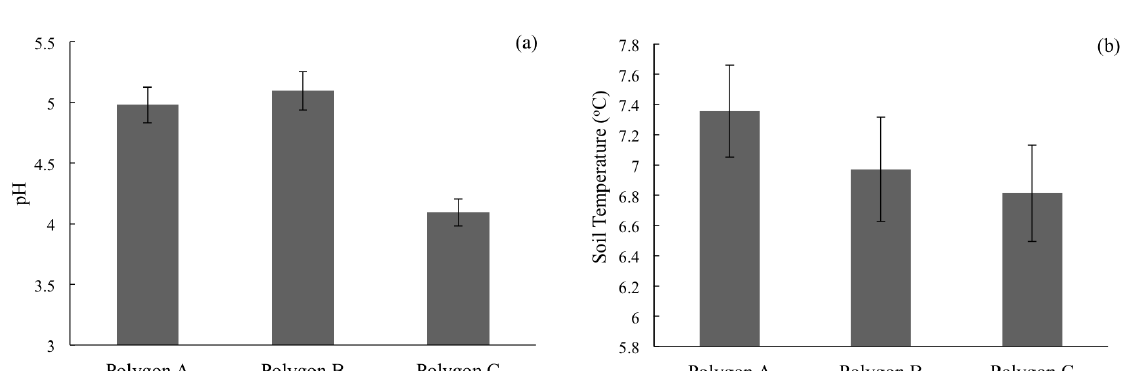
Figure 7. Environmental data from the three polygons studied during this experiment: ( a ) pH; ( b ) soil temperature; ( c ) dissolved oxygen; ( d ) oxidation-reduction potential; and ( e ) soil conductivity. Data was collected from both 7 and 10 cm depths over the five-week long experiment. Despite the close proximity (all within a ~10 m radius), there were differences in ( a ) pH, ( c ) dissolved oxygen, ( d ) oxidation-reduction potential, and ( e ) soil conductivity across polygons. Polygon C had a lower pH and higher dissolved oxygen than polygons A and B, while polygon A had a lower soil conductivity than polygons A and C. Oxidation-reduction potential showed the largest difference across polygons; polygon A had the lowest (most reducing) potential while polygon C had the highest (most oxidizing)